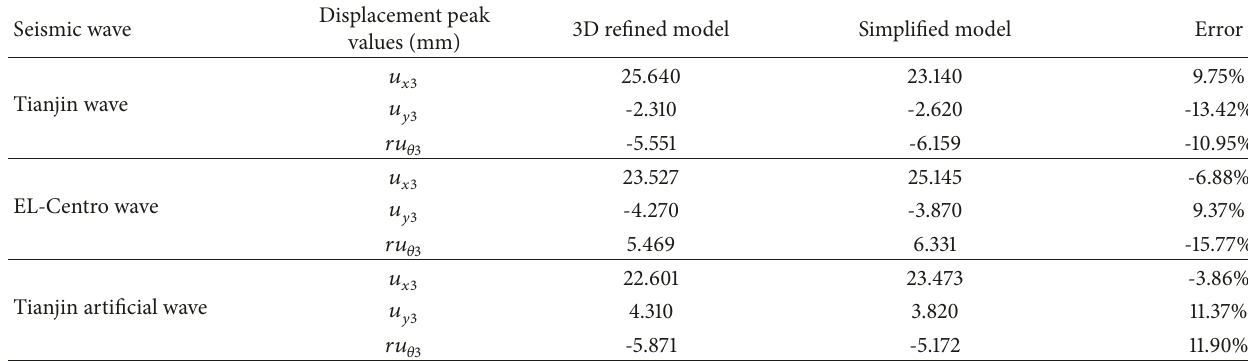
Table 2: The peak values of the top floor displacement under rare